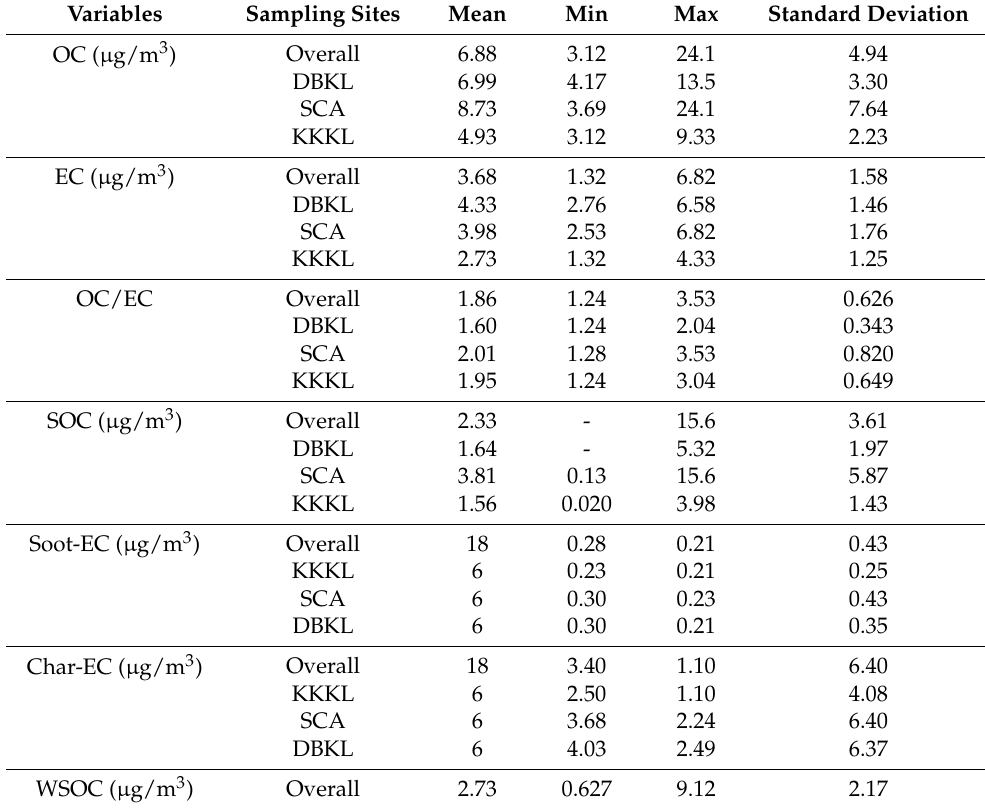
Table 1. Carbonaceous fractions in PM 2.5 from three sites in Kuala